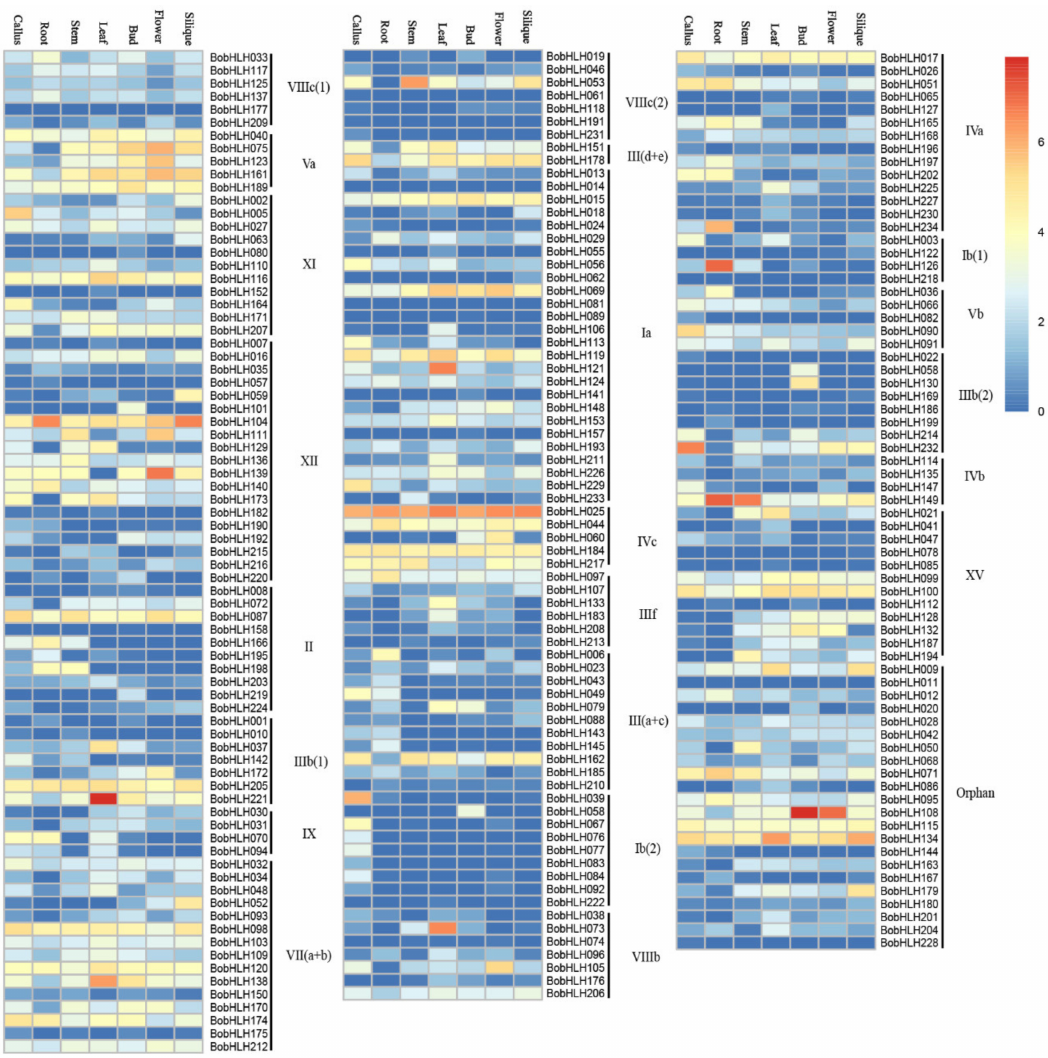
Figure 3. Expression profiles of BobHLH genes. Heat map representation of BobHLH genes in various organs / tissues, included callus, roots, stems, leaves, buds, flowers, and siliques. Expression levels of the BobHLH genes are shown as the log 2 (FPKM + 1), transformed FPKM values obtained from the RNA-Seq